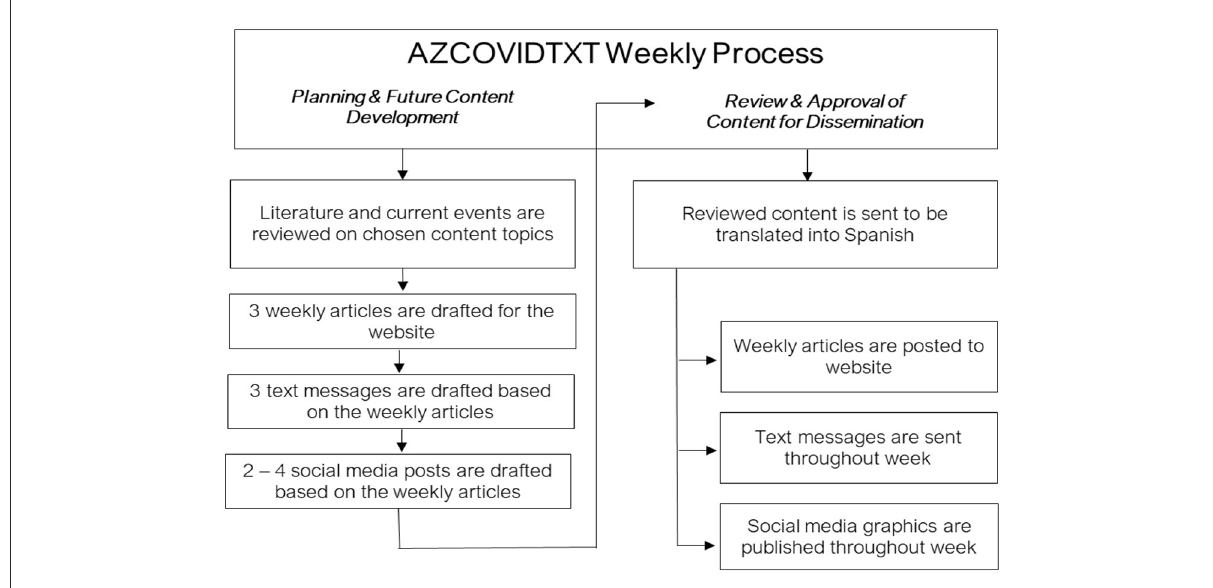
FIGURE1 Content development and dissemination process